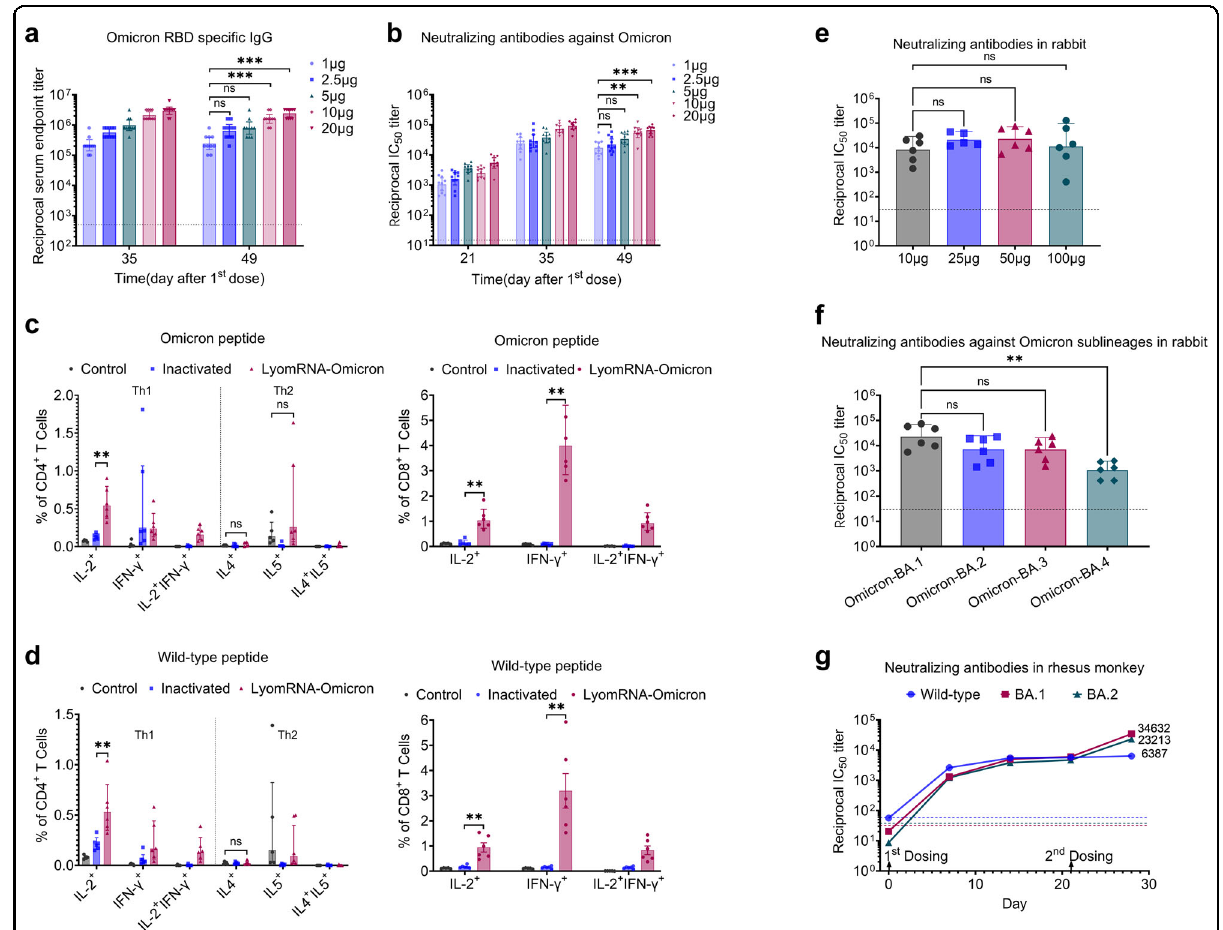
Fig. 3 LyomRNA-Omicron could simultaneously activate high levels of humoral and cellular immunity. a , b C57BL/6N mice ( n = 10) received two muscular injections of different doses of LyomRNA-Omicron. The time of the fi rst dose was considered as D0, and the second dose was given at D21. Plasma Omicron RBD-speci fi c IgG binding antibody titers ( a ) and titers of pseudovirus neutralizing antibodies at different time points following the fi rst dose ( b ) are shown. c , d C57BL/6N mice were vaccinated with 5 μ g of LyomRNA-Omicron or 0.65 U of the inactivated vaccine at an interval of 21 days. The spleens were obtained 28 days after the second shot for ICS. The control mice received normal saline. The frequencies of IL2/IFN- γ / IL4/IL5-positive CD4 + T cells and IL2/IFN- γ -positive CD8 + killer cells speci fi c for SARS-CoV-2 Omicron NTD-RBD peptide ( c ) or wild-type NTD – RBD peptide ( d ) were detected. e , f New Zealand rabbits, received two muscular injections of vaccines at an interval of 21 days. The plasma-neutralizing antibodies for pseudoviruses ( e ) and pseudoviruses of all Omicron variants at a dose of 50 μ g ( f ) were detected 14 days after the last immunization. g Six-year-old monkeys were immunized twice with 50 μ g of LyomRNA-Omicron ( n = 3) at a 3-week interval. Blood samples were collected before and after vaccination. Neutralizing antibodies against the wild-type, Omicron variant BA.1 and BA.2 were tested by a VSV-pseudovirus-based system. Immunogenicity data were collected at 7, 14, 21, and 28 days after the fi rst dose of LyomRNA-Omicron. a , b , e , f Group comparisons were made by Kruskal – Wallis ANOVA with Dunn ’ s multiple comparisons test. c , d Vaccine groups were compared by a two-sided Mann – Whitney test. ns, not signi fi cant. ** P < 0.01, *** P < 0.001. Data are presented as the geometric means ± 95% con fi dence interval ( a , b , e , f , g ) or geometric means ± geometric SD ( c , d ). Dotted lines represent assay limits of detection for a , b , e , f and plasma pseudovirus neutralizing antibody titers of control monkeys without immunization for g